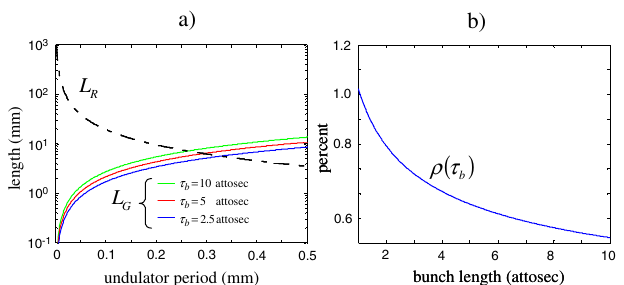
FIG. 2. (Color) (a) Rayleigh length L and one-dimensional R versus undulator period for a 20 fC electron FEL gain length L G 0 . (b) FEL parameter (cid:8) versus bunch duration (cid:2) for an bunch (cid:3) u b undulator period of 0.3 mm and 20 fC bunch